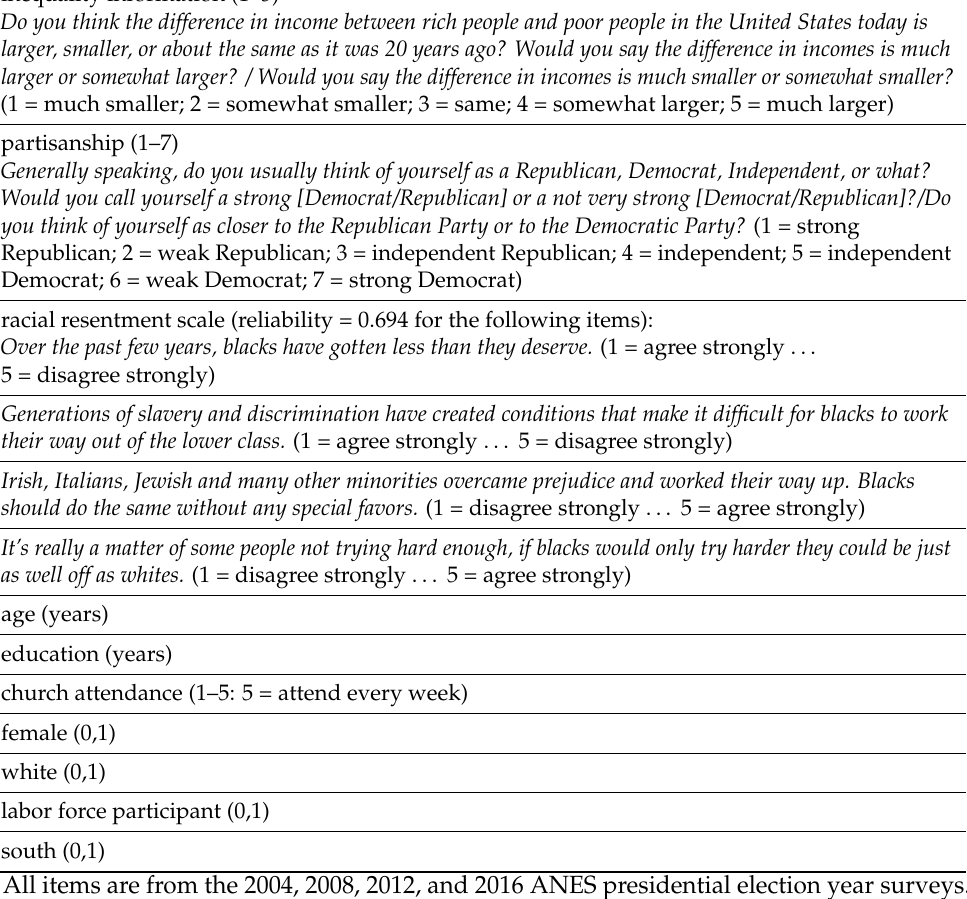
Table 2. Independent variables a . inequality information